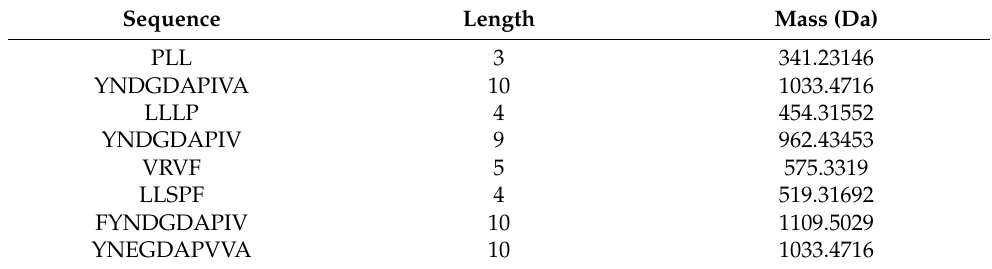
Table 2. Peptide sequencing of RFP.